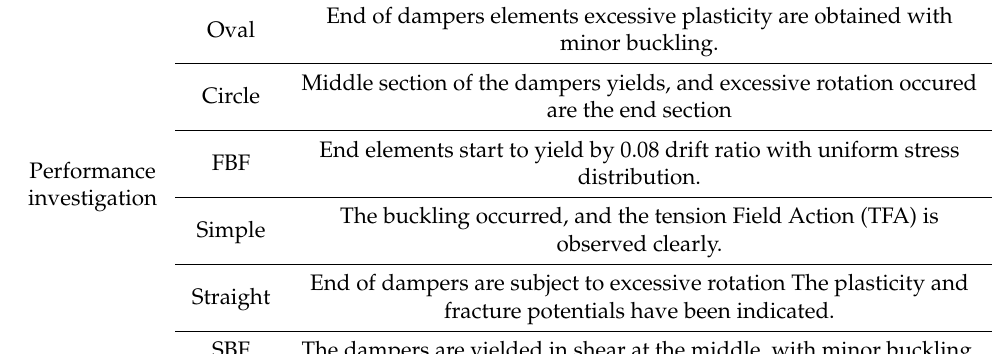
Table 3. The mode of behavior for SRLs up to at 0.08 drift ratio.